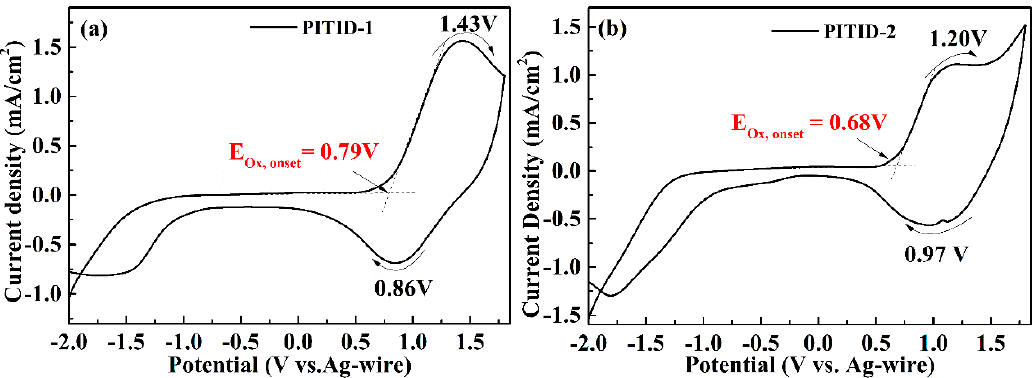
Figure 3. C–V curves of the copolymer films, PITID-1 ( a ) and PITID-2 ( b ), on the spray-coated indium tin oxide (ITO) substrates in 0.2 M TBAPF 6 /ACN electrolyte solution at a scan rate of 100 mV/s between − 2 and 1.8 V.